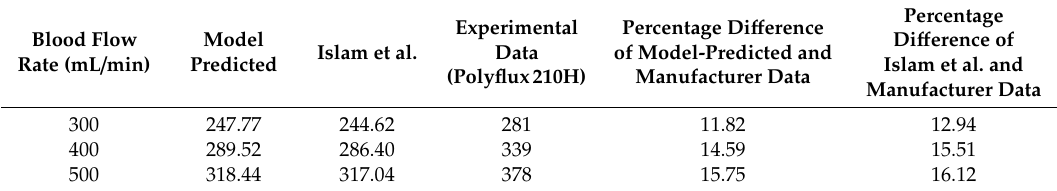
Table 3. Comparison of this model results with literature data [21,22].